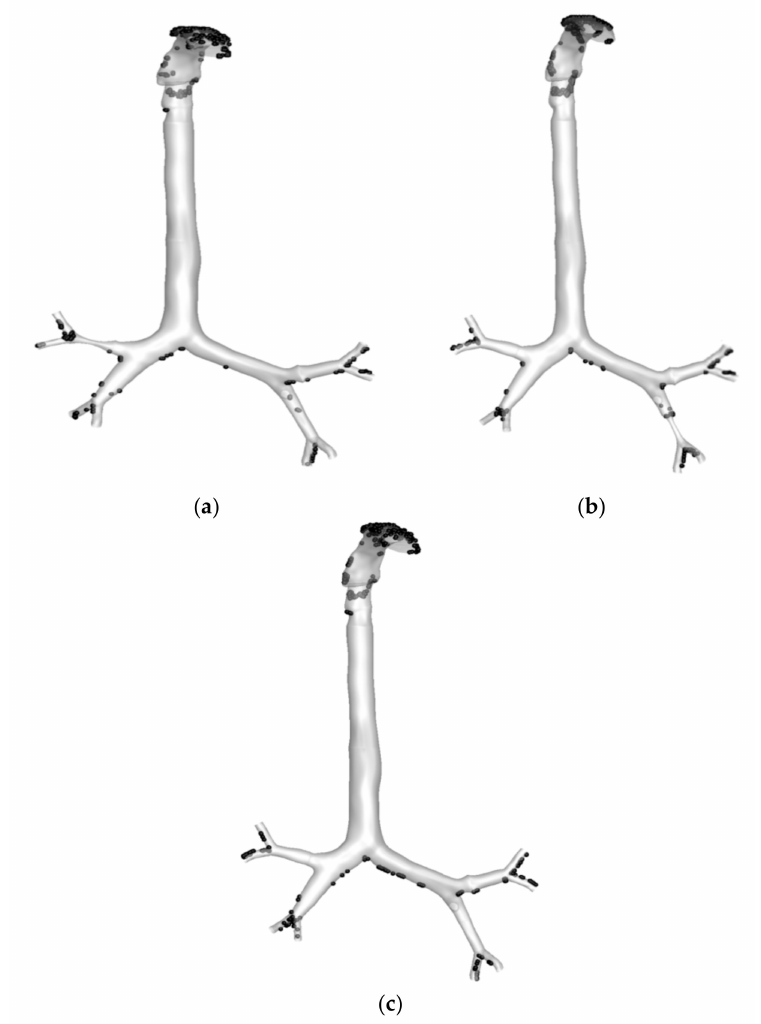
Figure 16. Deposition fraction of 2.5 µ m particles in healthy and stenosis airways at 30 lpm: ( a ) right stenosis, ( b ) left stenosis, and ( c ) healthy